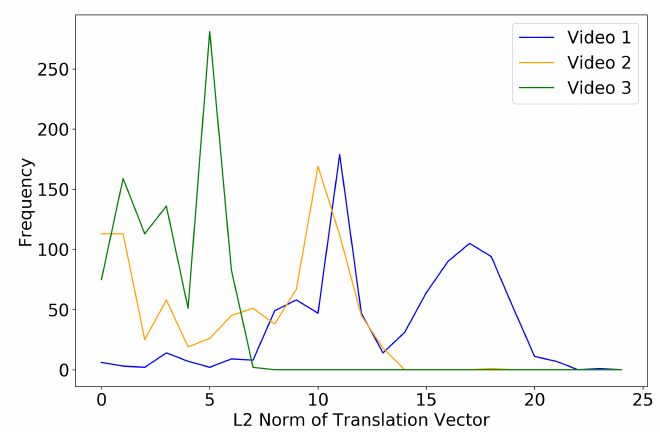
Figure 11. The distribution of the norms of translation vectors for three capillary videos. Each x - and y -axis indicates the L2 norm of a translation vector and the occurrence frequency of each